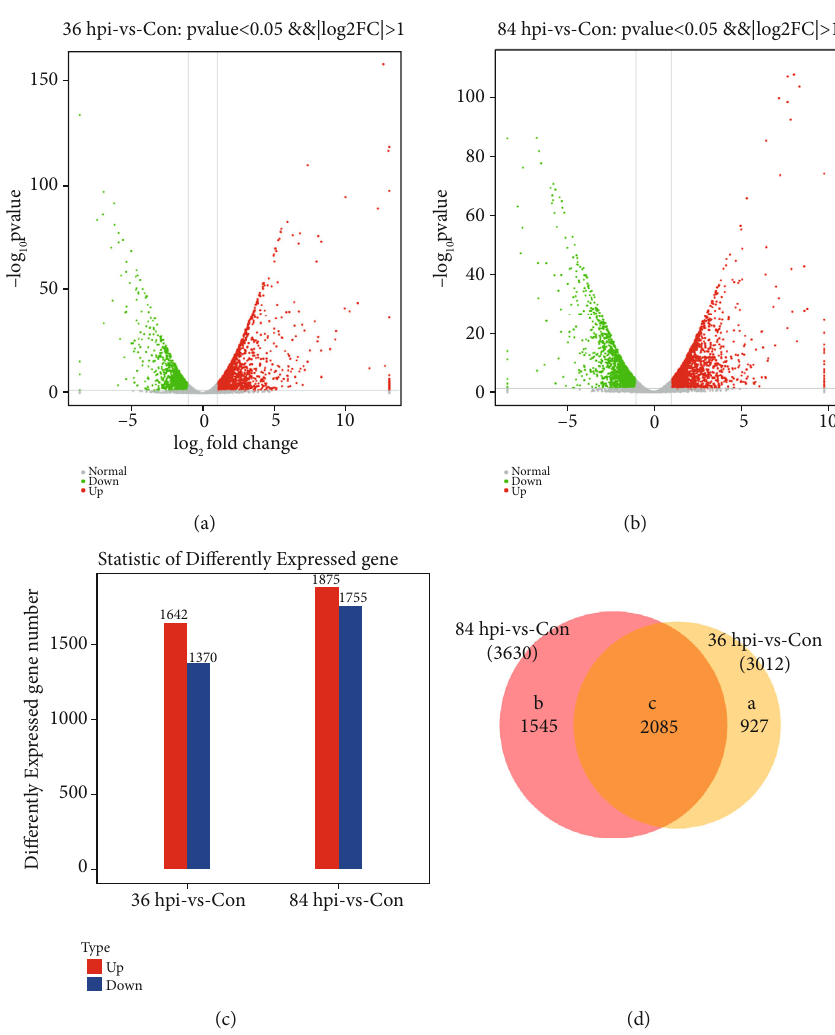
Figure 2: Di ff erentially expressed genes (DEGs) of S . lycopersici . (a) Volcano plot of the global comparison of transcript pro fi les between Con and 36 hpi. Gray dots indicate genes of no signi fi cance. Red dots indicate upregulated genes meeting the thresholds of log 2 fold change > 1 and padj < 0 : 05 . Green dots indicate downregulated genes meeting the thresholds of log 2 foldchange < − 1 and padj < 0 : 05 . (b) Volcano plot of the global comparison of transcript pro fi les between Con and 84 hpi. (c) Statistical histogram of the DEGs. Red and blue columns represent the up- and downregulated genes, respectively. (d) Venn plot of common and unique DEGs between the di ff erent comparison groups. Region a represents the number of DEGs only in 36 hpi-vs-Con. Region b represents the number of DEGs only in 84hpi-vs-Con. Region c represents the number of DEGs present in both comparison